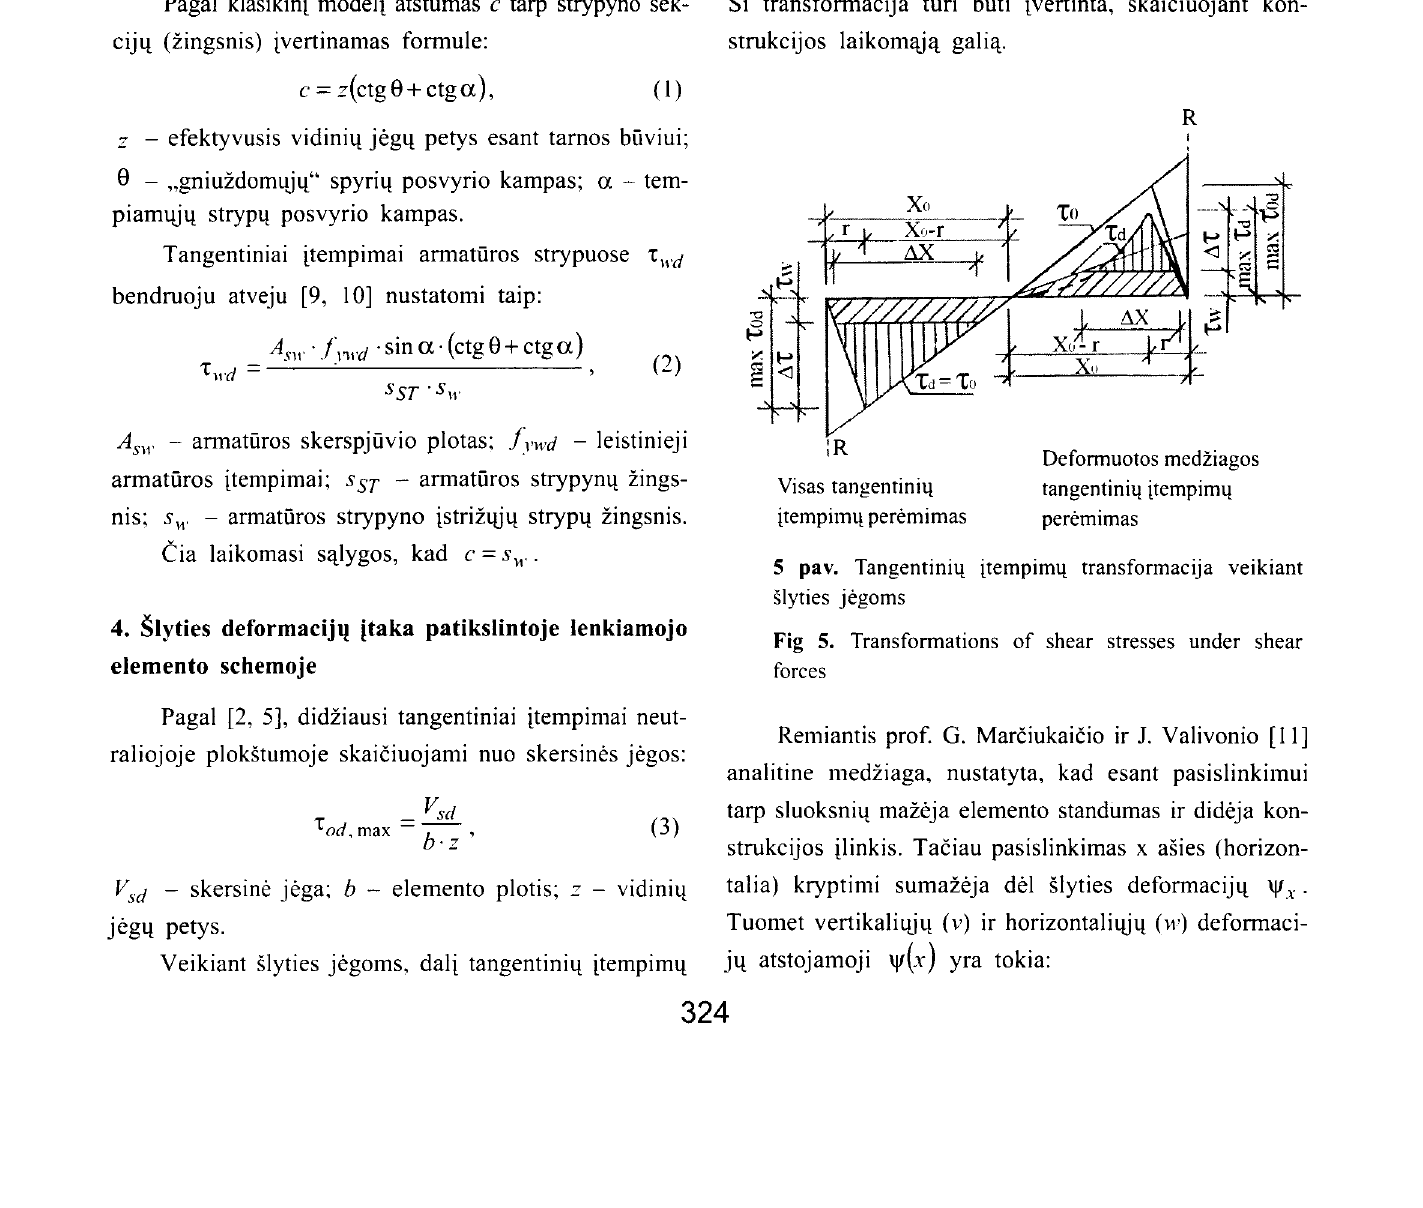
Skaiciuojam4.il! jegl! pasiskirstymas menamos santva ros modelyje pagal EN2 [7] pavaizduotas 4 paveiksle. Pagal klasikini modeli atstumas c tarp strypyno sek cijl! (zingsnis) ivertinamas formule: